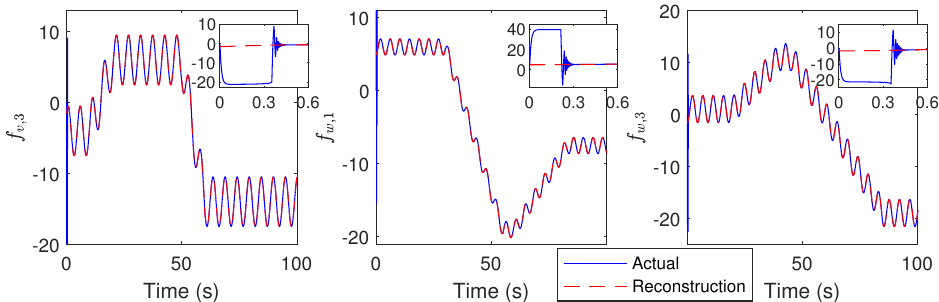
Figure 11. The faults affecting system (53) (solid) and their estimates from the distributed SMOs (dashed) for the case u d , i = 0 for i = 1,2,3.